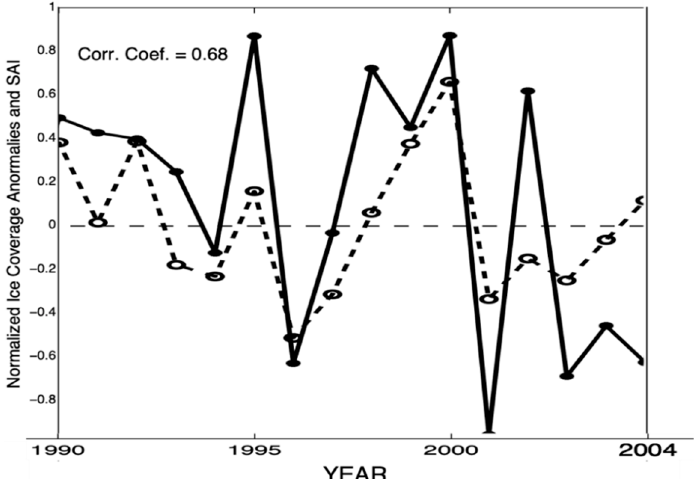
Figure 11. Correlation between the time series of the annual normalized ice-covered area anomaly (solid line) and Siberia-Aleutian index (dashed line). The sea ice data are from the ROMS solution and the Siberia-Aleutian index is from the NCEP.